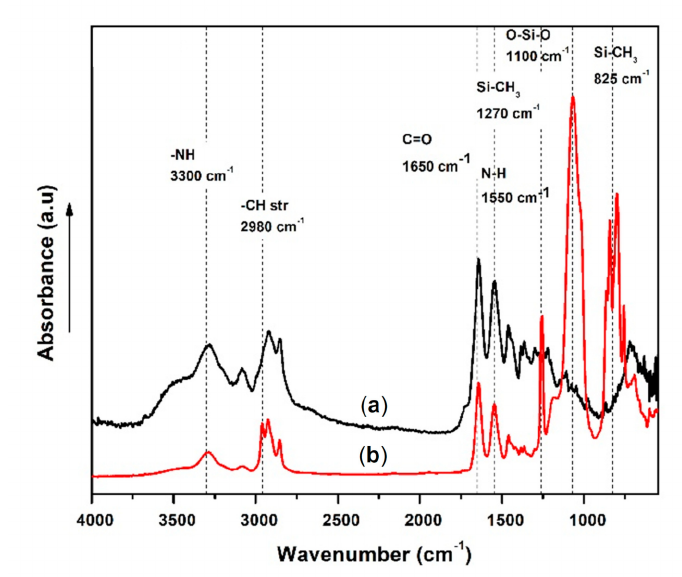
Figure 6. FTIR spectra of PA ( a ) and PDMS/PA ( b ) electrospun fiber